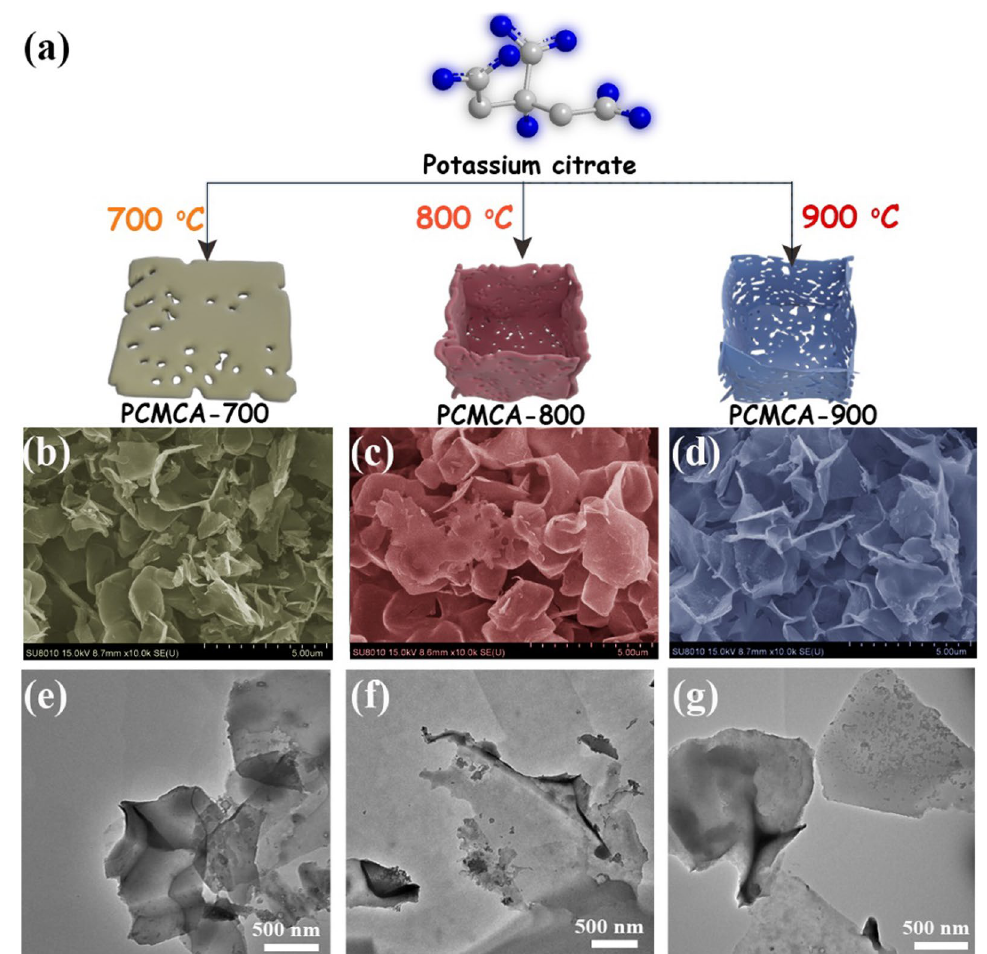
Fig. 1 a Preparation process of PCM-derived hierarchical porous carbon adsorbent; b – d SEM images and e – g TEM images of